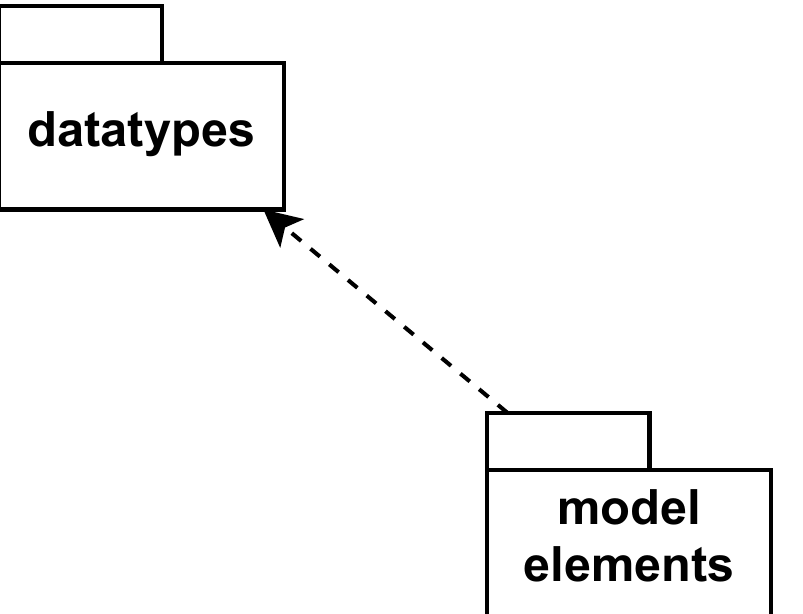
Figure 4. The cyber-resilience domain model—package-level